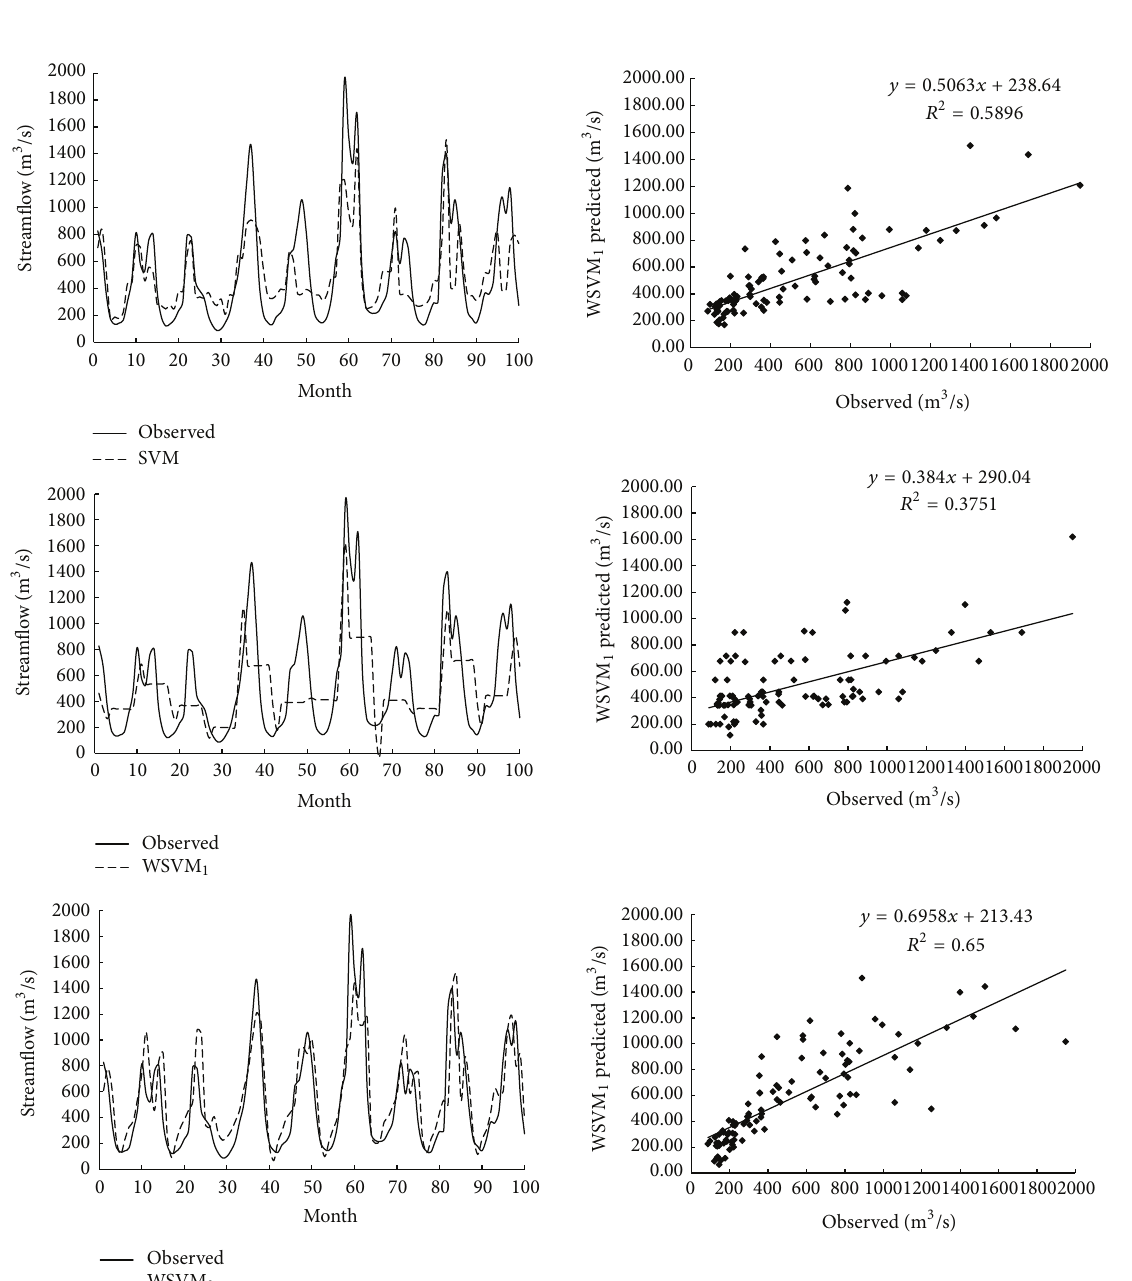
Figure 5: Predicted and observed streamflow in the testing period by SVM, WSVM 1 , and WSVM 2